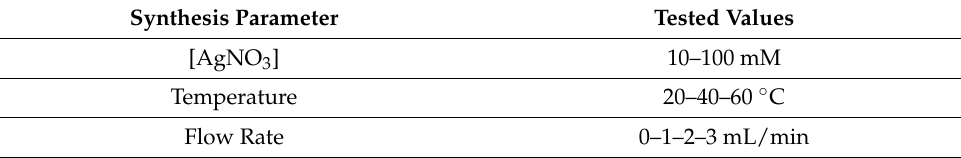
Table 1. Synthesis parameters along with the corresponding tested values.